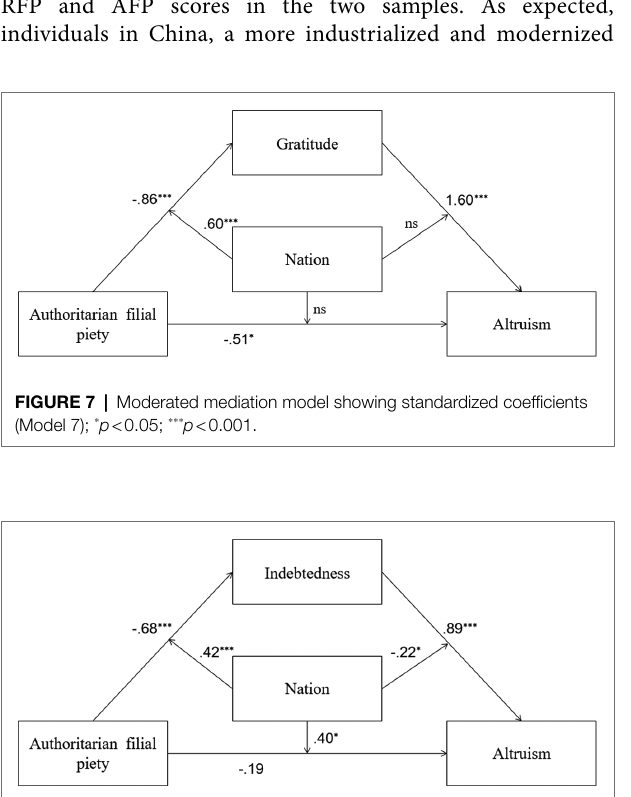
FIGURE 8 | Moderated mediation model showing standardized coefficients (Model 8); * p < 0.05; *** p <